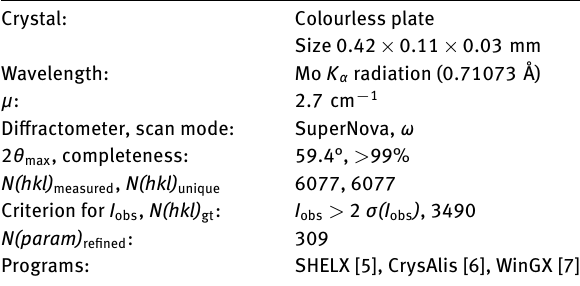
Table 2: Fractional atomic coordinates and isotropic or